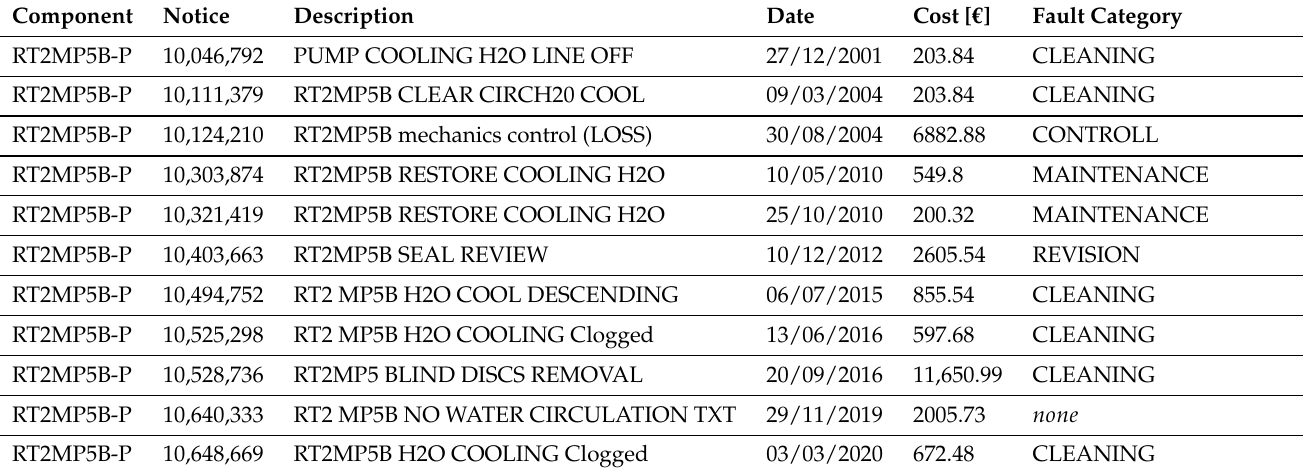
Table 9. Example of standard structure obtained for the pump RT2MP5B-P.